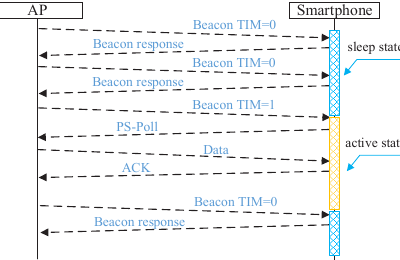
Figure 2. The behavior of router retrieves network